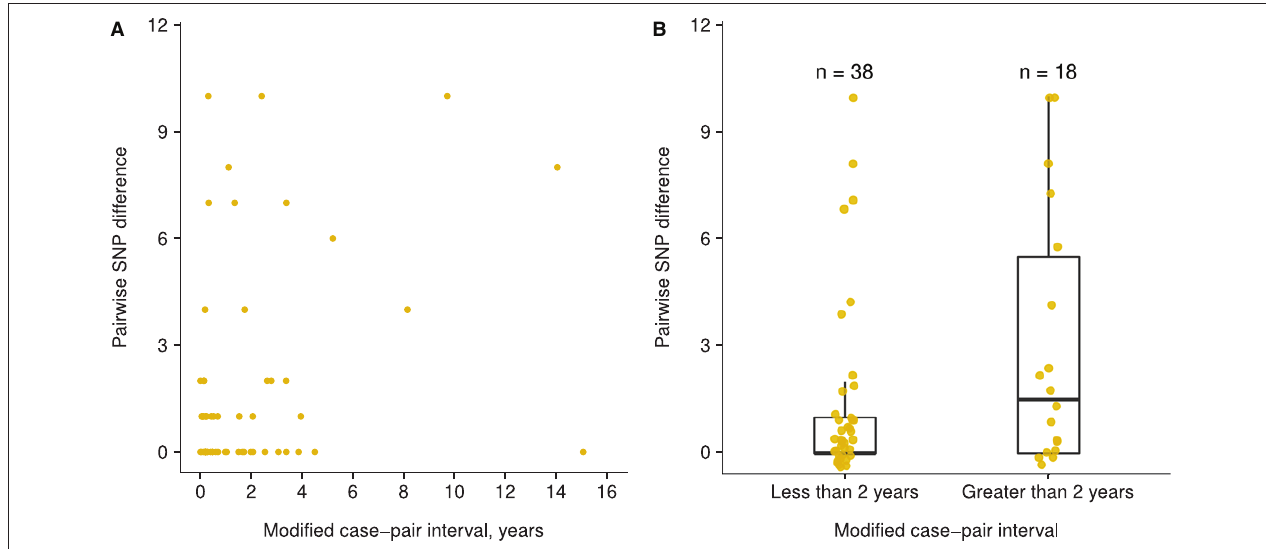
FIGURE 4 | Association between modified case-pair interval and pairwise single nucleotide polymorphism (SNP) difference between genotype-matched source–secondary case pairs in Los Angeles County, California, 2015–2018 a . a The modified case-pair interval is defined as the time between the estimated midpoint of the source patient’s TB infectious period and the sample collection date of the secondary patient. Each dot corresponds to a source–secondary case pair. (A) Scatter plot of modified case-pair interval, in years, against pairwise SNP distance. (B) Pairwise SNP differences of case pairs with modified case-pair intervals defined as recent transmission (during the previous 2 years) or reactivation (transmission occurred > 2 years ago).